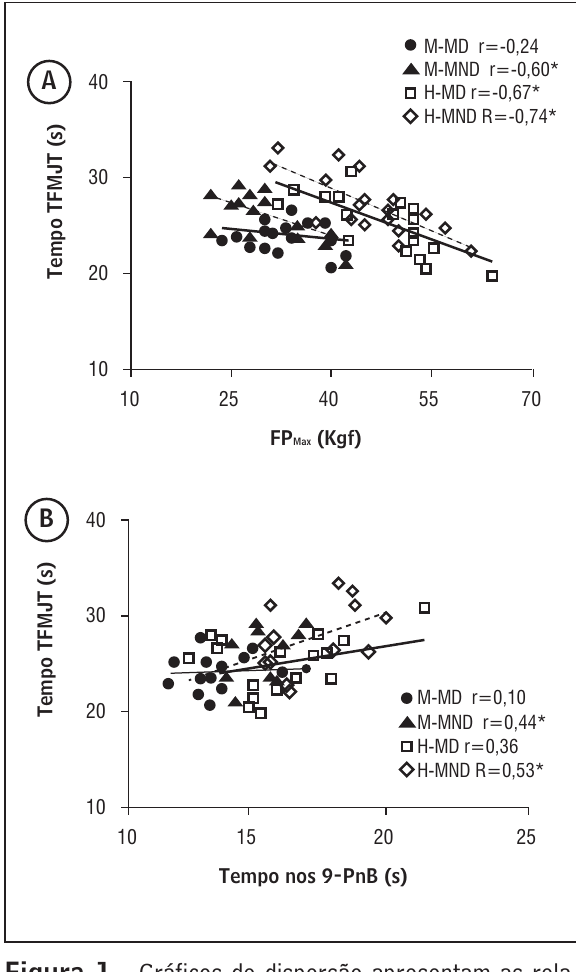
Figura 1 - Gráficos de dispersão apresentam as rela- ções entre as variáveis e os respectivos va- lores de coeficiente de correlação (r) para as combinações: mulher-mão dominante (M- MD), mulher-mão não dominante (M-MND), homem mão dominante (H-MD) e homem -mão não dominante